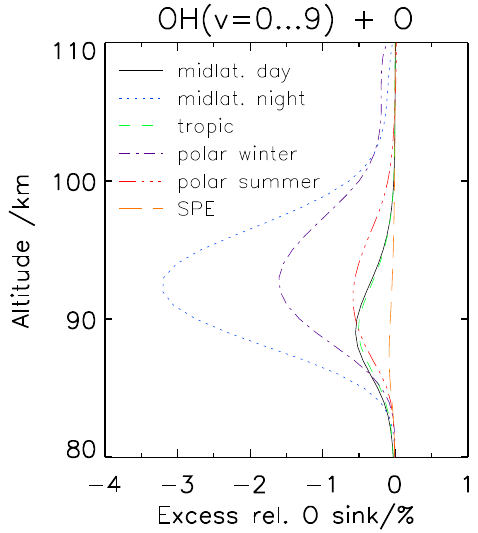
Fig. 12. Excess relative atomic oxygen sink by consideration of vibrationally excited OH in the OH+O reaction as a function of al- titude for various atmospheres.